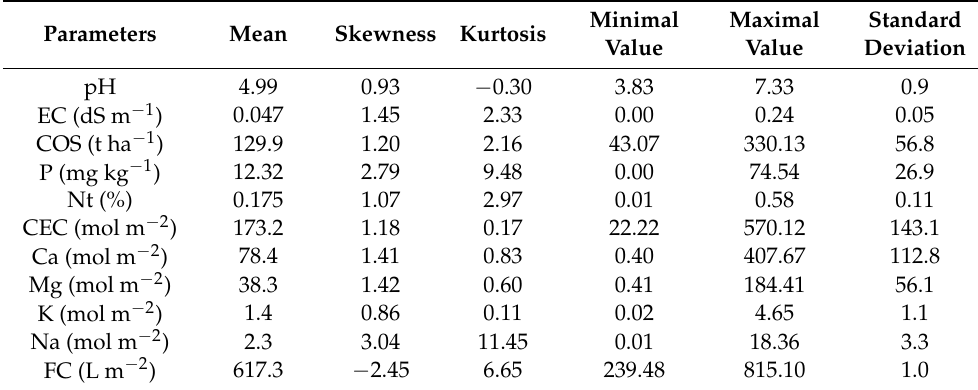
Table 1. Descriptive statistics of soil properties expressed per unit